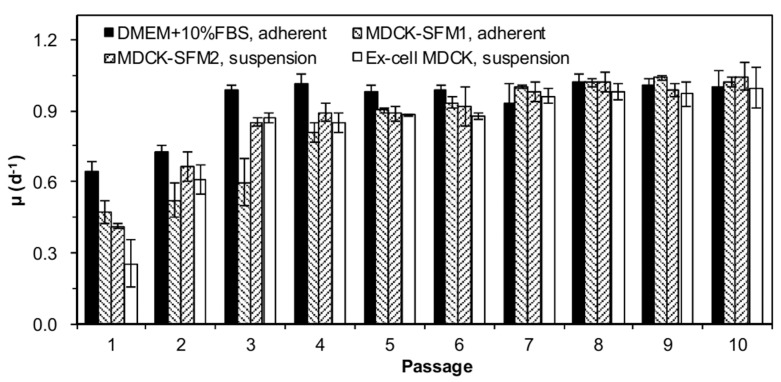
MDCK cell growth stability in different cultures.Adherent MDCK cells were seeded at 4×104 cells/cm2 in 150 cm2 T-flasks, and suspension cells were seeded at 3×105 cells/mL in 125 mL shaker flasks. Cells were subcultured every 2 days for 10 passages after thawing and average specific growth rates were monitored.